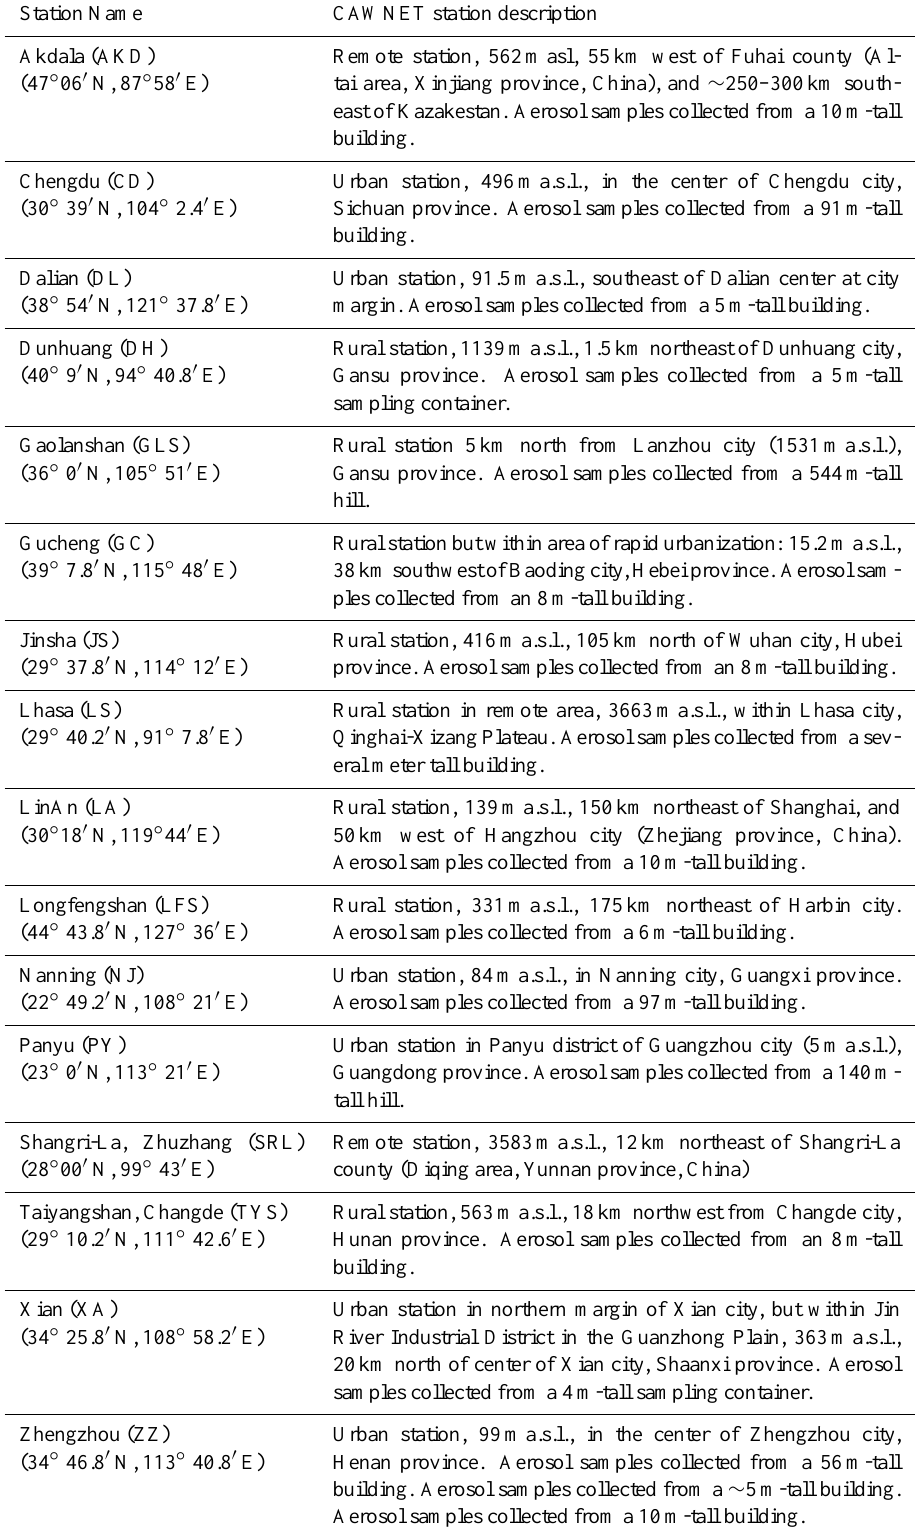
Table 1. CMA Atmosphere Watch Network (CAWNET) site and sampling